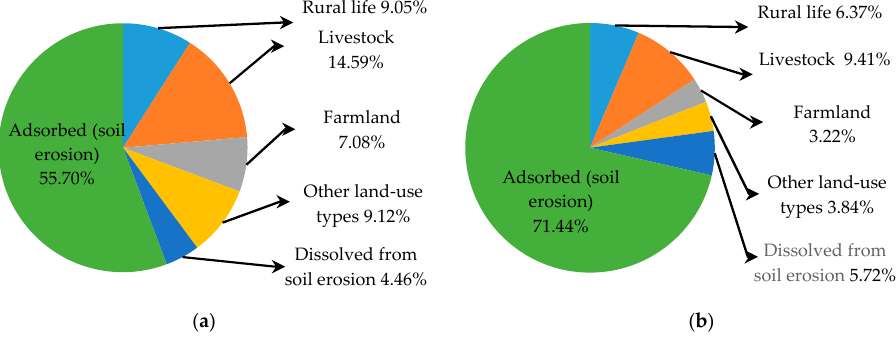
Figure 13. Source contribution percentages of ( a ) TN and ( b ) TP discharged into Lake Chenghai.